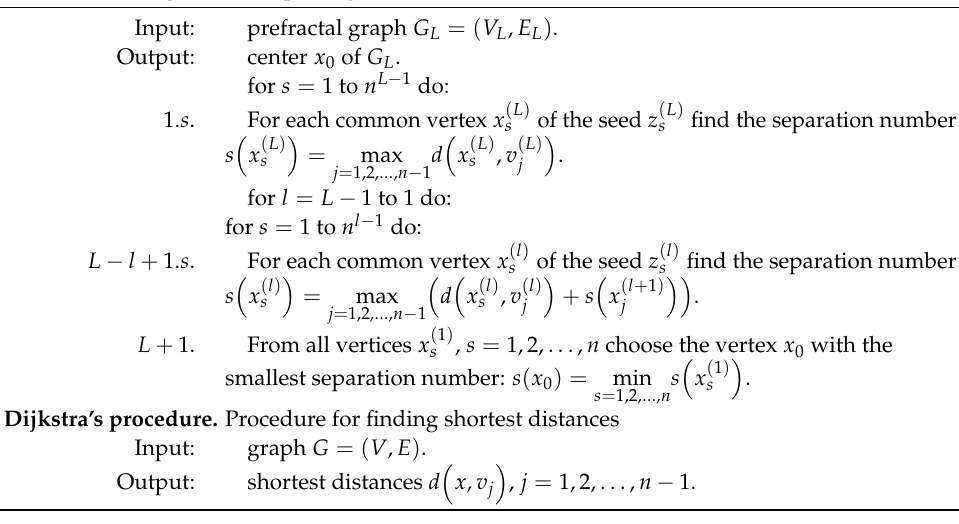
Algorithm 1. Algorithm for placing the center ( α 0